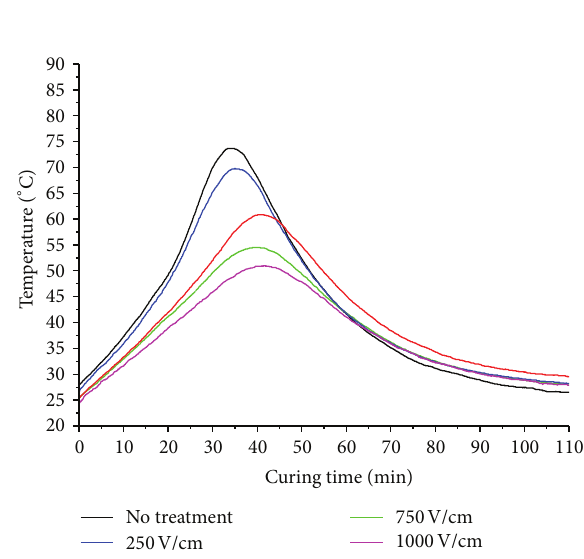
Figure 2: Single fiber pull-out test.